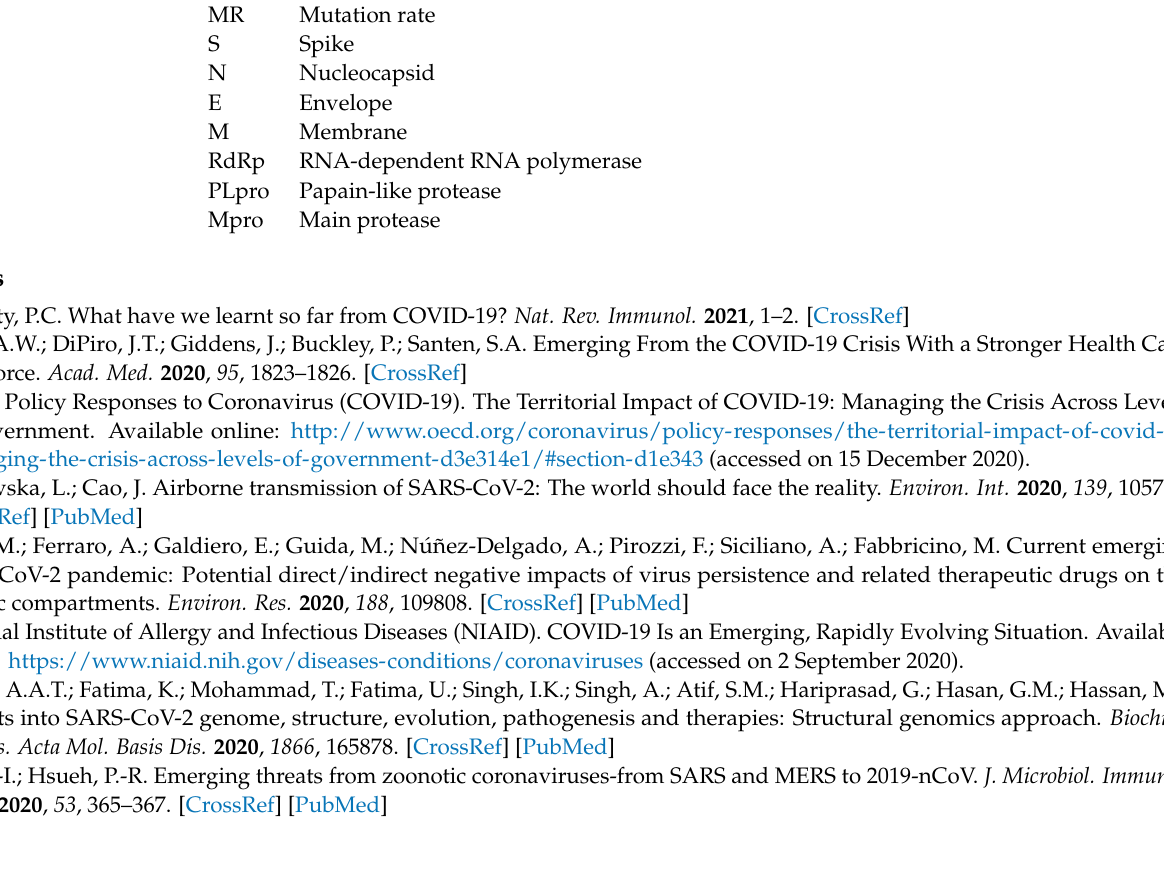
Figure S1. Residue mutation rates for the following SARS-CoV-2 proteins: NSP1, NSP2, NSP3,